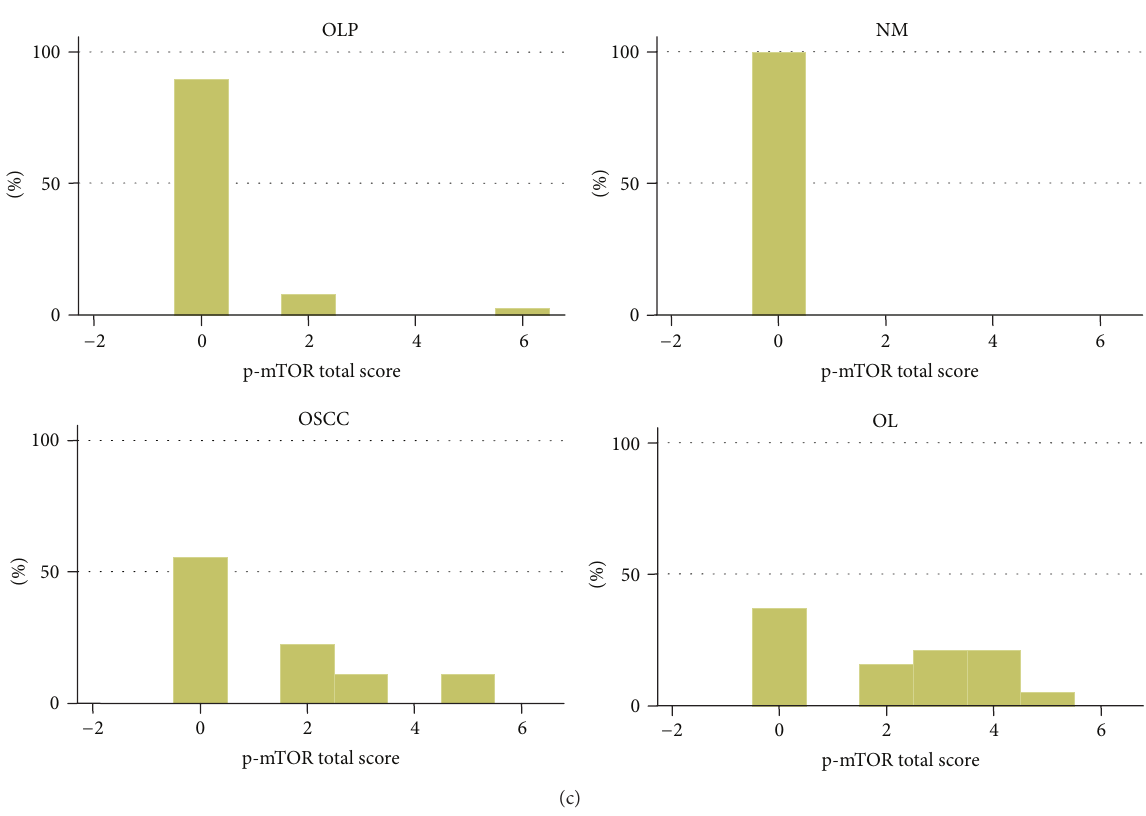
Figure 5: Graph of immunohistochemical results for p-mTOR. Distribution of cases per lesion category according to (a) positivity score, (b) intensity score, and (c) total score. Abbreviations: OLP: oral lichen planus; NM: normal mucosa; OSCC: oral squamous cell carcinoma; OL: Oral